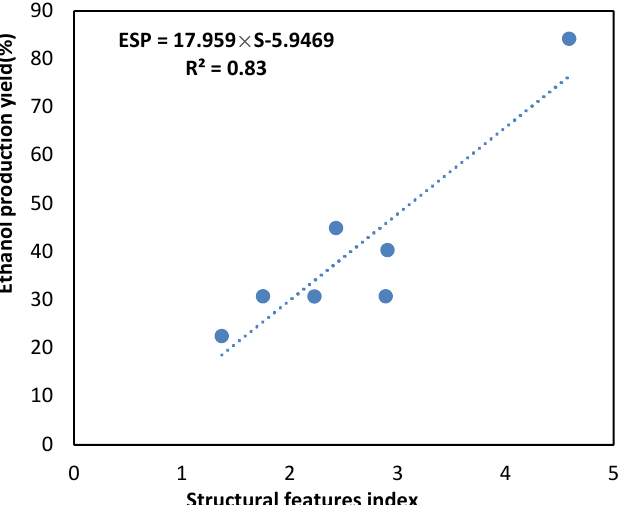
ESP = 17.959 × S-5.9469